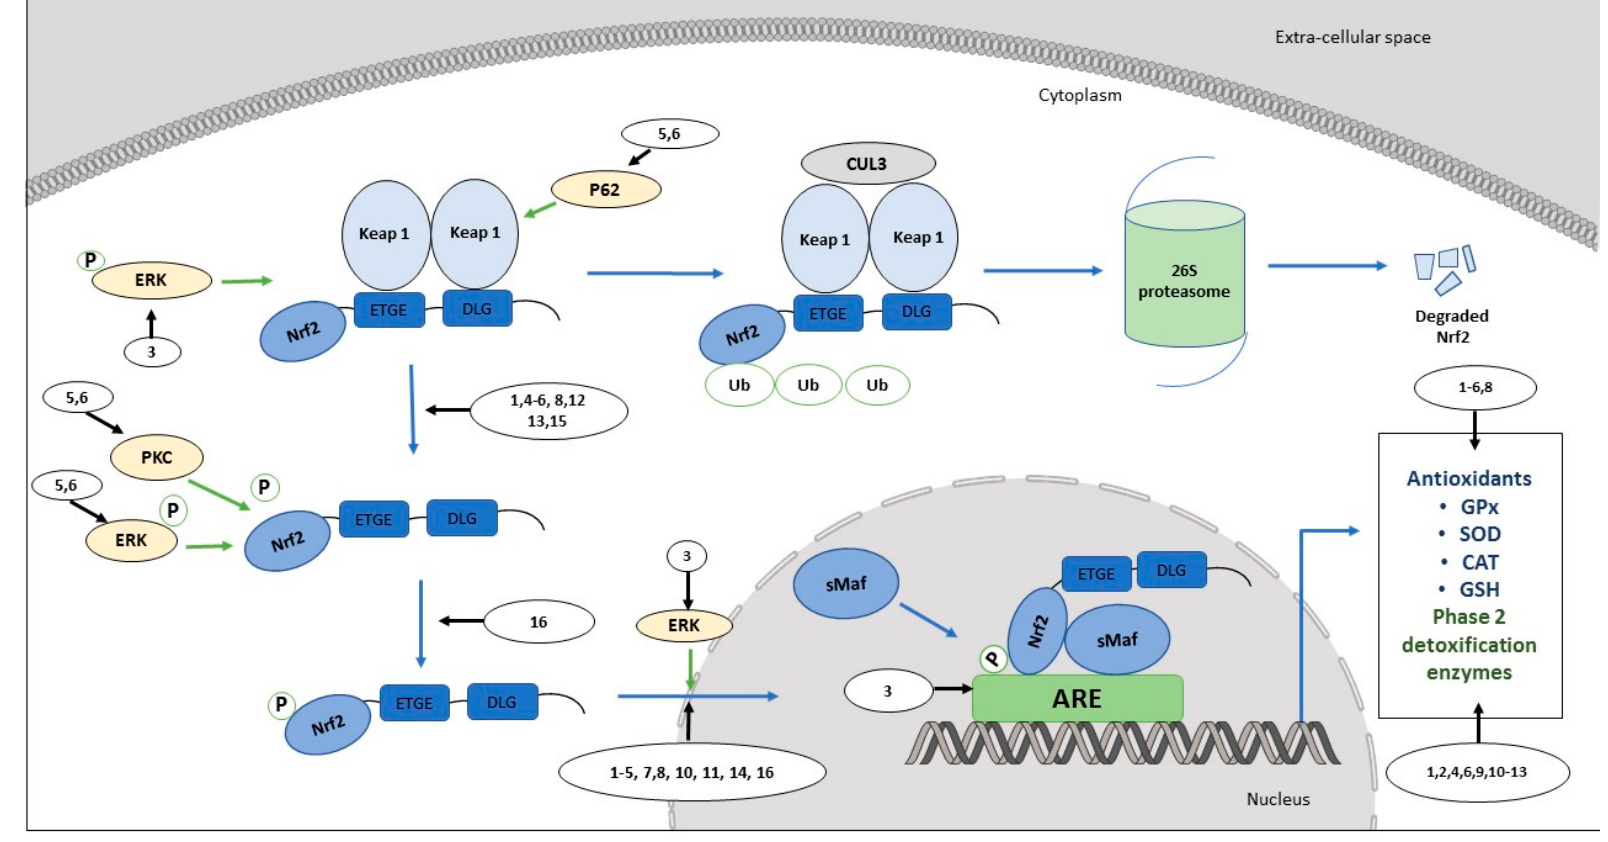
Figure 1. Role of dietary flavonoids in the regulation of the Nrf2 / ARE pathway in normal cells. In normal cells, flavonoids have been shown to activate the Nrf2 / ARE pathway in maintaining redox homeostasis. Under normal physiological conditions, Keap1 protein inhibits the activation of the Nrf2 protein by its interactions with the Nrf2 protein and ubiquitination-associated Nrf2 degradation. Upon oxidative stress caused by ROS, the oxidation of cysteine residues of Keap1 makes the Nrf2 dissociate from the Keap1 protein, followed by the stabilization of Nrf2 via phosphorylation. Phosphorylated Nrf2 translocates into the nucleus and binds to ARE along with the sMaf transcription factor. ARE-driven downstream antioxidant defenses and phase 2 detoxifying proteins will be expressed, leading to the restoration of